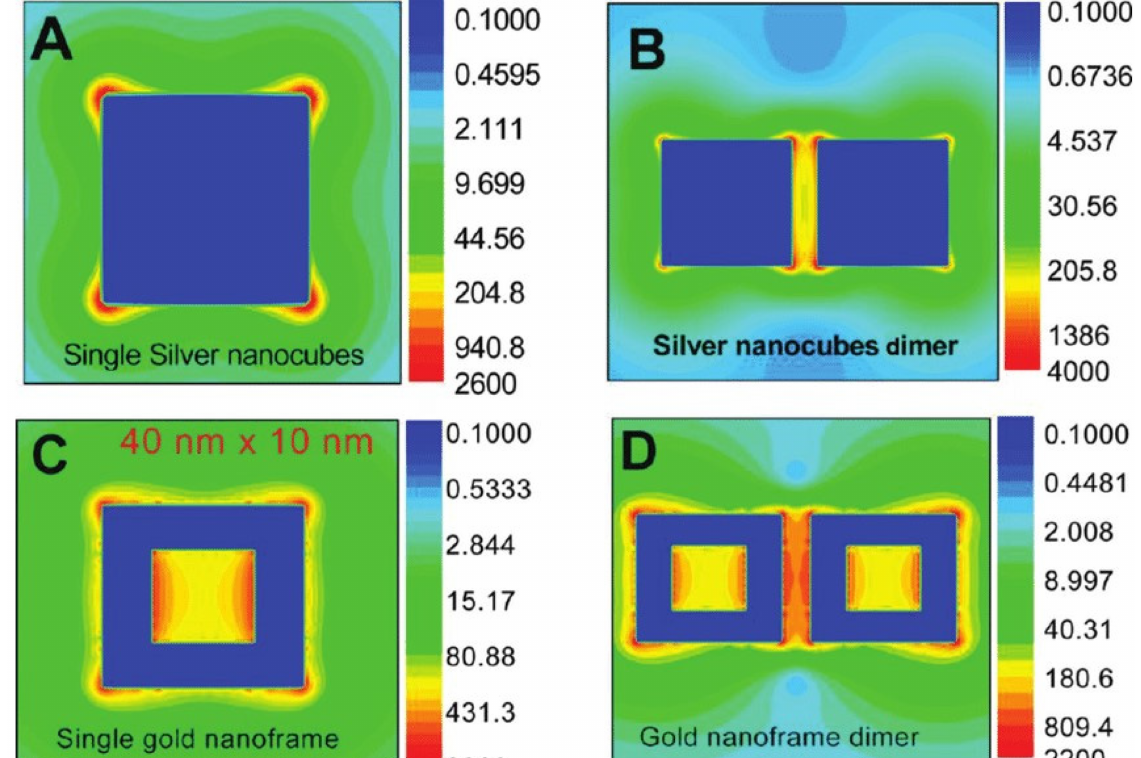
Figure 2. Plasmon electric field enhancement for Ag nanocubes and their dimer, and for Au nanoframes and their dimer, calculated using the discrete dipole approximation. ( A ) Individual Ag nanocube, ( B ) dimer of Ag nanocubes, ( C ) single Au nanoframe, and ( D ) dimer of Au nanoframes. Reproduced with permission from [11]. Copyright 2014 American Chemical